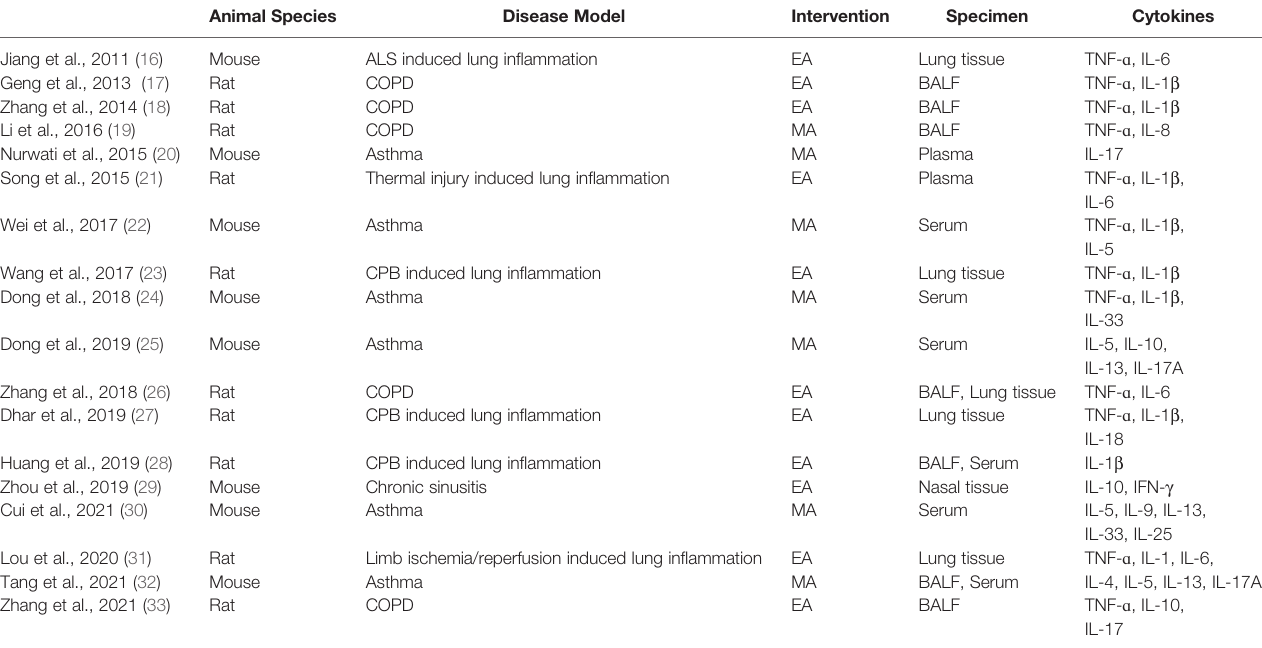
TABLE 2 | Study Characteristics.